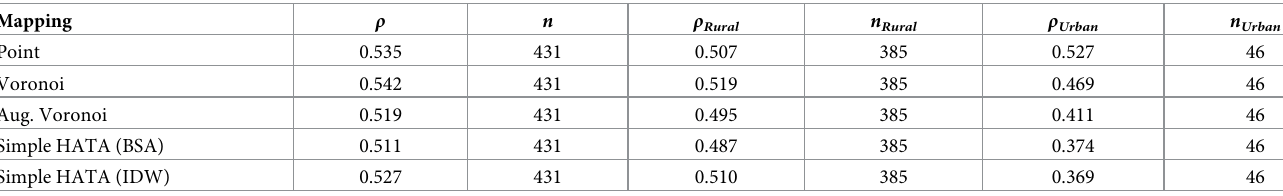
Table 8. Area-level correlation of estimated and true unemployment rate & sample size.